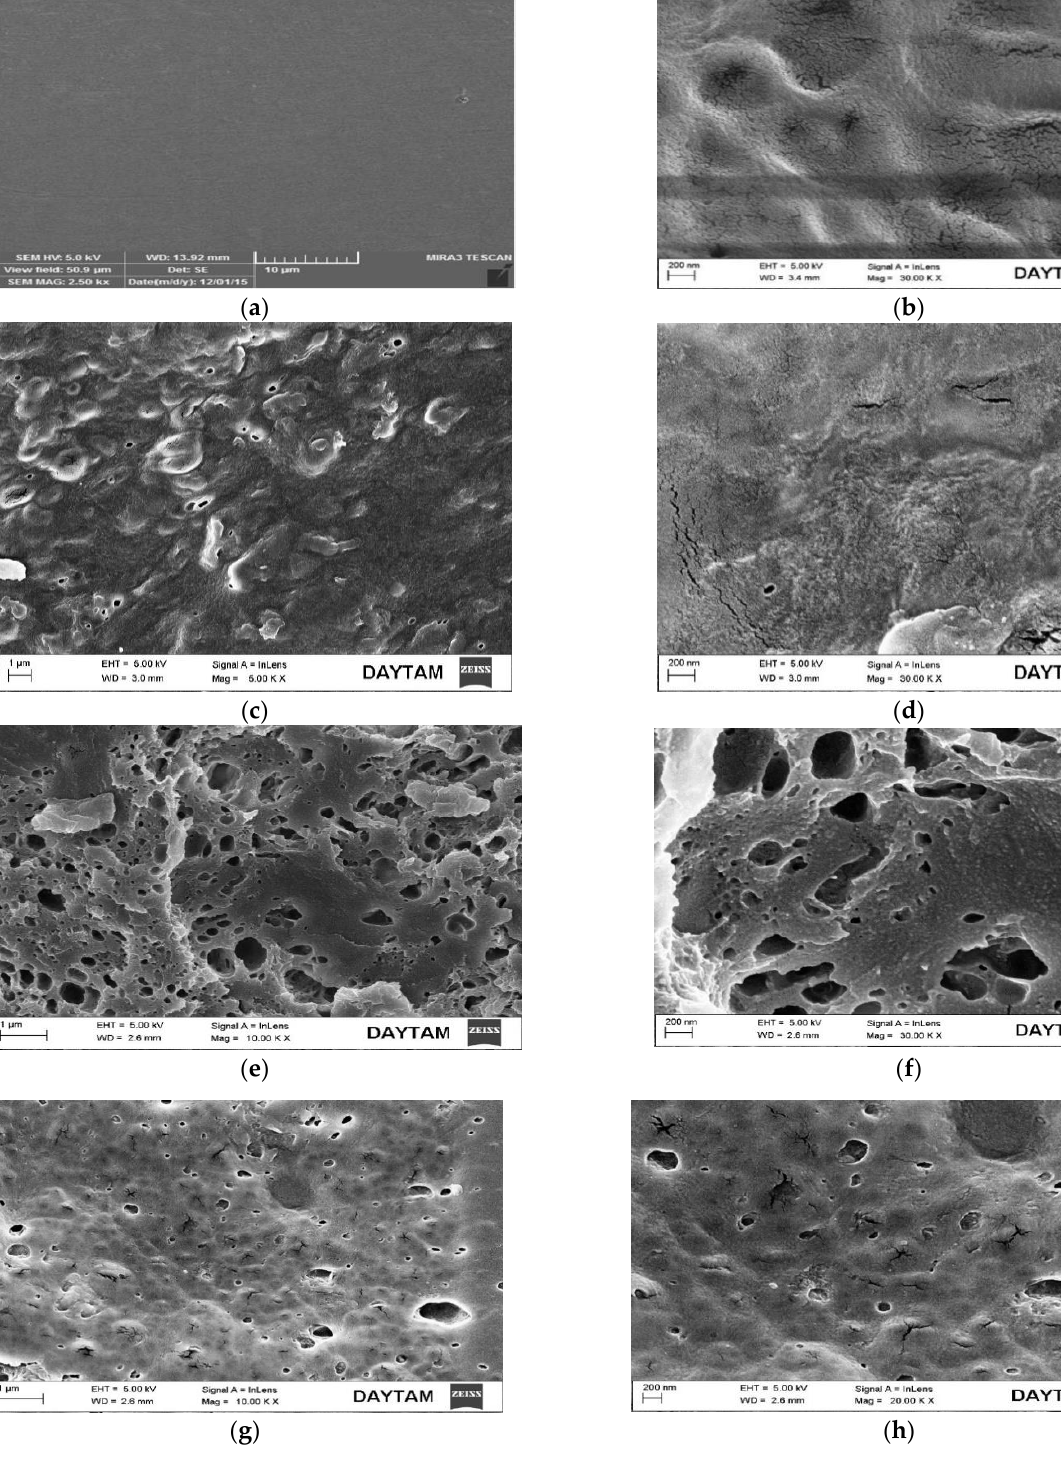
Figure 5. SEM images of corn starch CS ( a ), wheat gluten ( b ), CS 1 ( c , d ), CS 2 ( e , f ), and CS 3 ( g , h ) nanocomposite films.